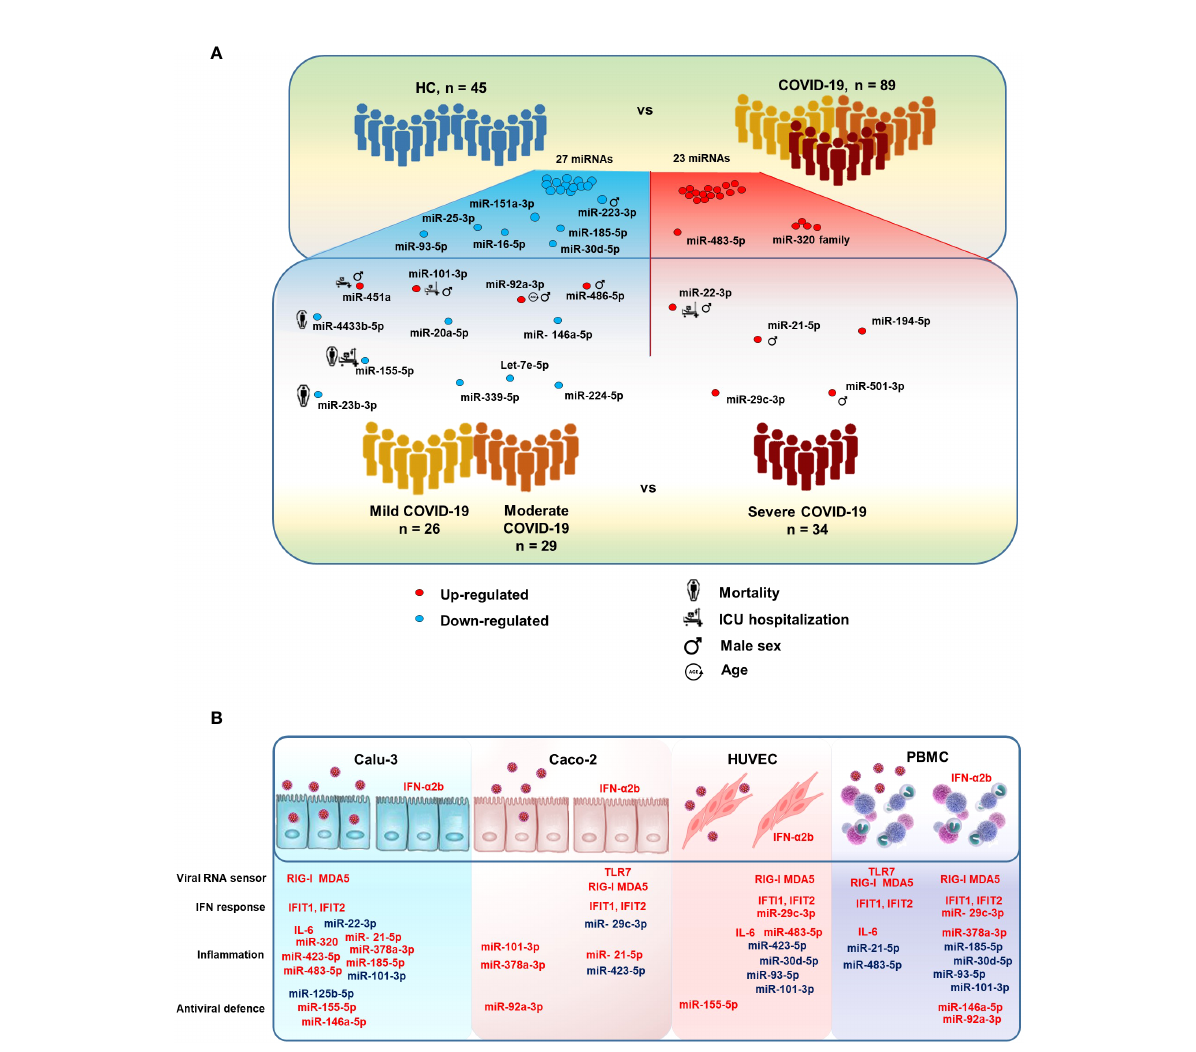
FIGURE 8 MicroRNAs modulated in COVID-19 patients. (A) Illustration of the study design and results, highlighting relevant serum miRNAs that were differentially expressed between COVID-19 patients vs. HC and between severe COVID-19 vs. mild and moderate COVID-19. The fi gure also shows serum miRNAs signi fi cantly associated with the risk of intensive care unit (ICU) hospitalization and death in COVID-19 patients, as well as male sex and age. (B) Illustration of the results of in vitro experiments, summarizing the effects of SARS-CoV-2 infection and IFN- a 2b treatment on human lung (Calu-3), colon (Caco-2), endothelial (HUVEC), and peripheral blood mononuclear cells (PBMCs). Upregulated and downregulated miRNAs are represented in red and blue,